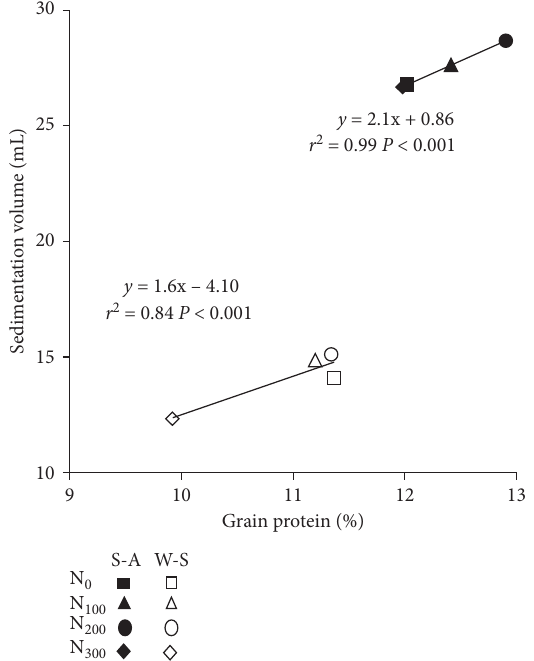
Figure 4: Relationship between sedimentation volume and grain protein for nine wheat cultivars grown under four nitrogen rate and two growing seasons, summer-autumn (S-A) and winter-spring (W-S). Data correspond to average of